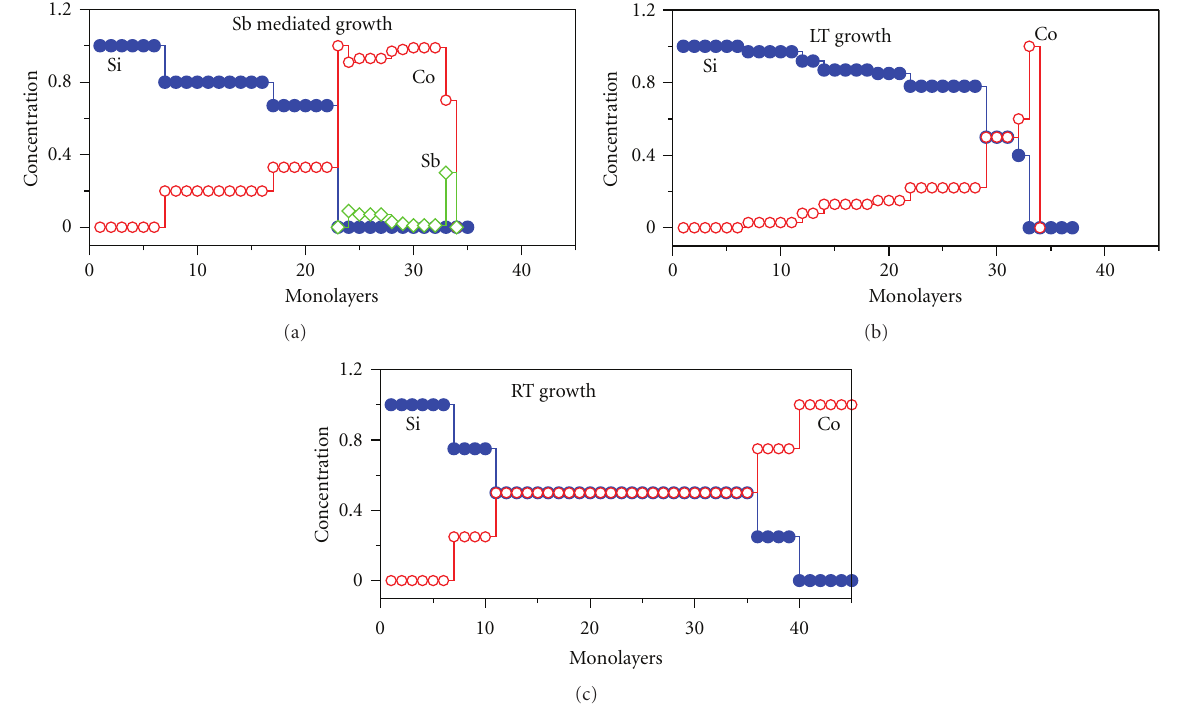
Figure 5: Co and Si (and Sb) concentrations as derived by RUMP simulations from the HRBS data of Figures 3 and 4. (c) Growth of 23.4 ML of Co on Si at room temperature, (b) 5.93 ML of Co deposited at low temperature ( − 60 ◦ C), and (a) growth of 19 ML of Co on Si with Sb as a surfactant. They seem to be representative for the interface structure in a stationary state. The free surface of the three samples is located at the right-most rim of the profiles. Layer 0 was deliberately put into the Si